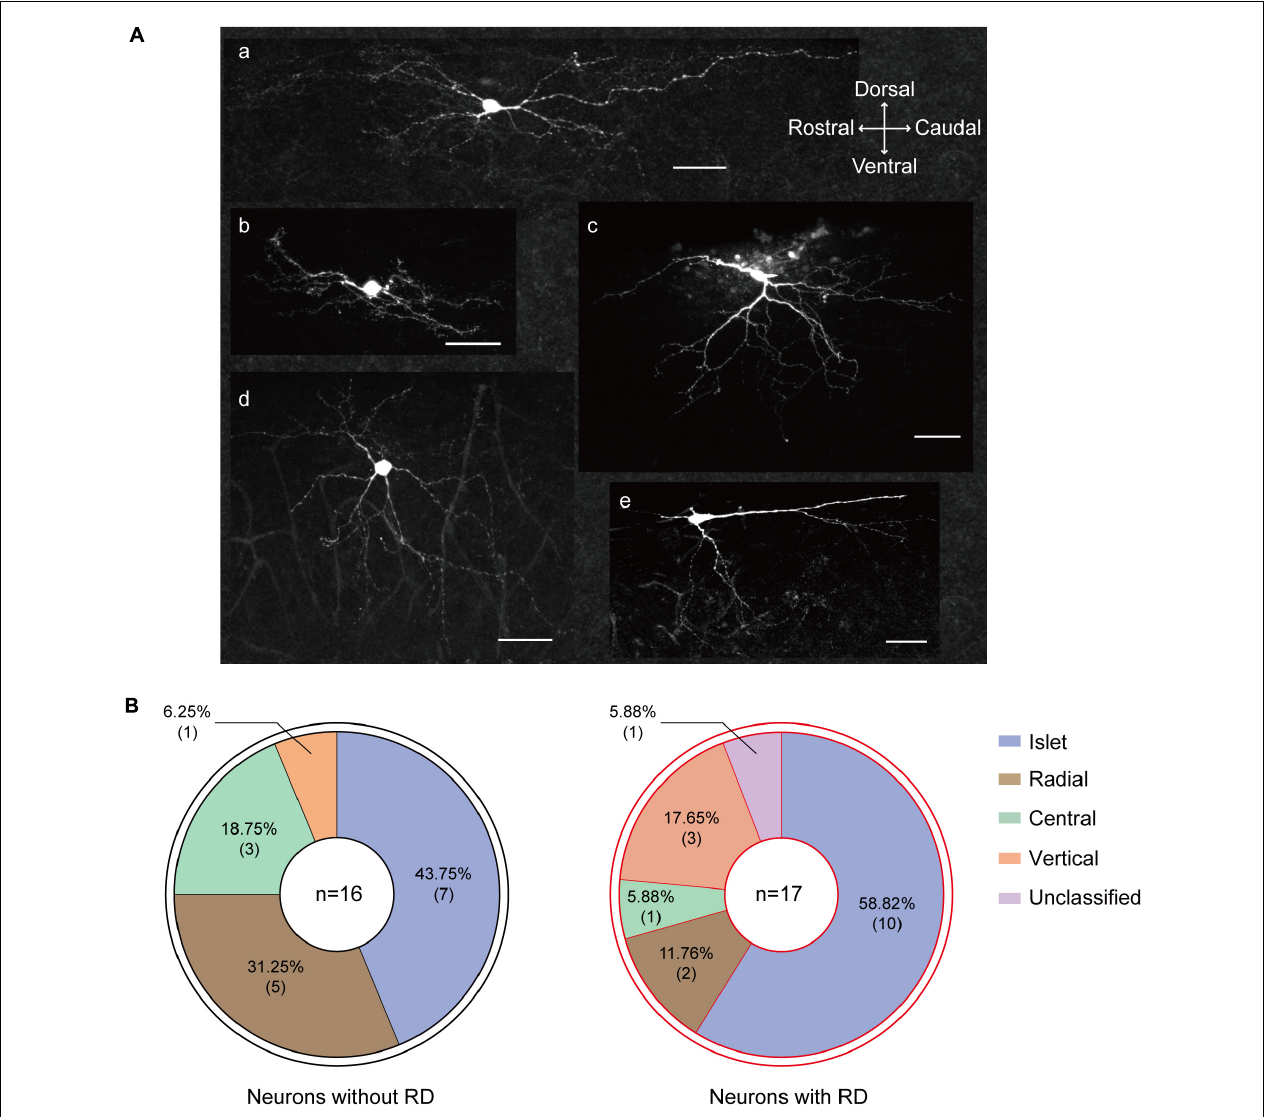
FIGURE 6 | Morphological heterogeneity of RD-expressing SG neurons. (A) Confocal images of SG neurons with RD labeled with biocytin. (a) islet, (b) central, (c) vertical, (d) radial, (e) unclassified. (B) Proportion of SG neurons with (right) or without (left) RD exhibiting different morphologies. RD, rebound depolarization.